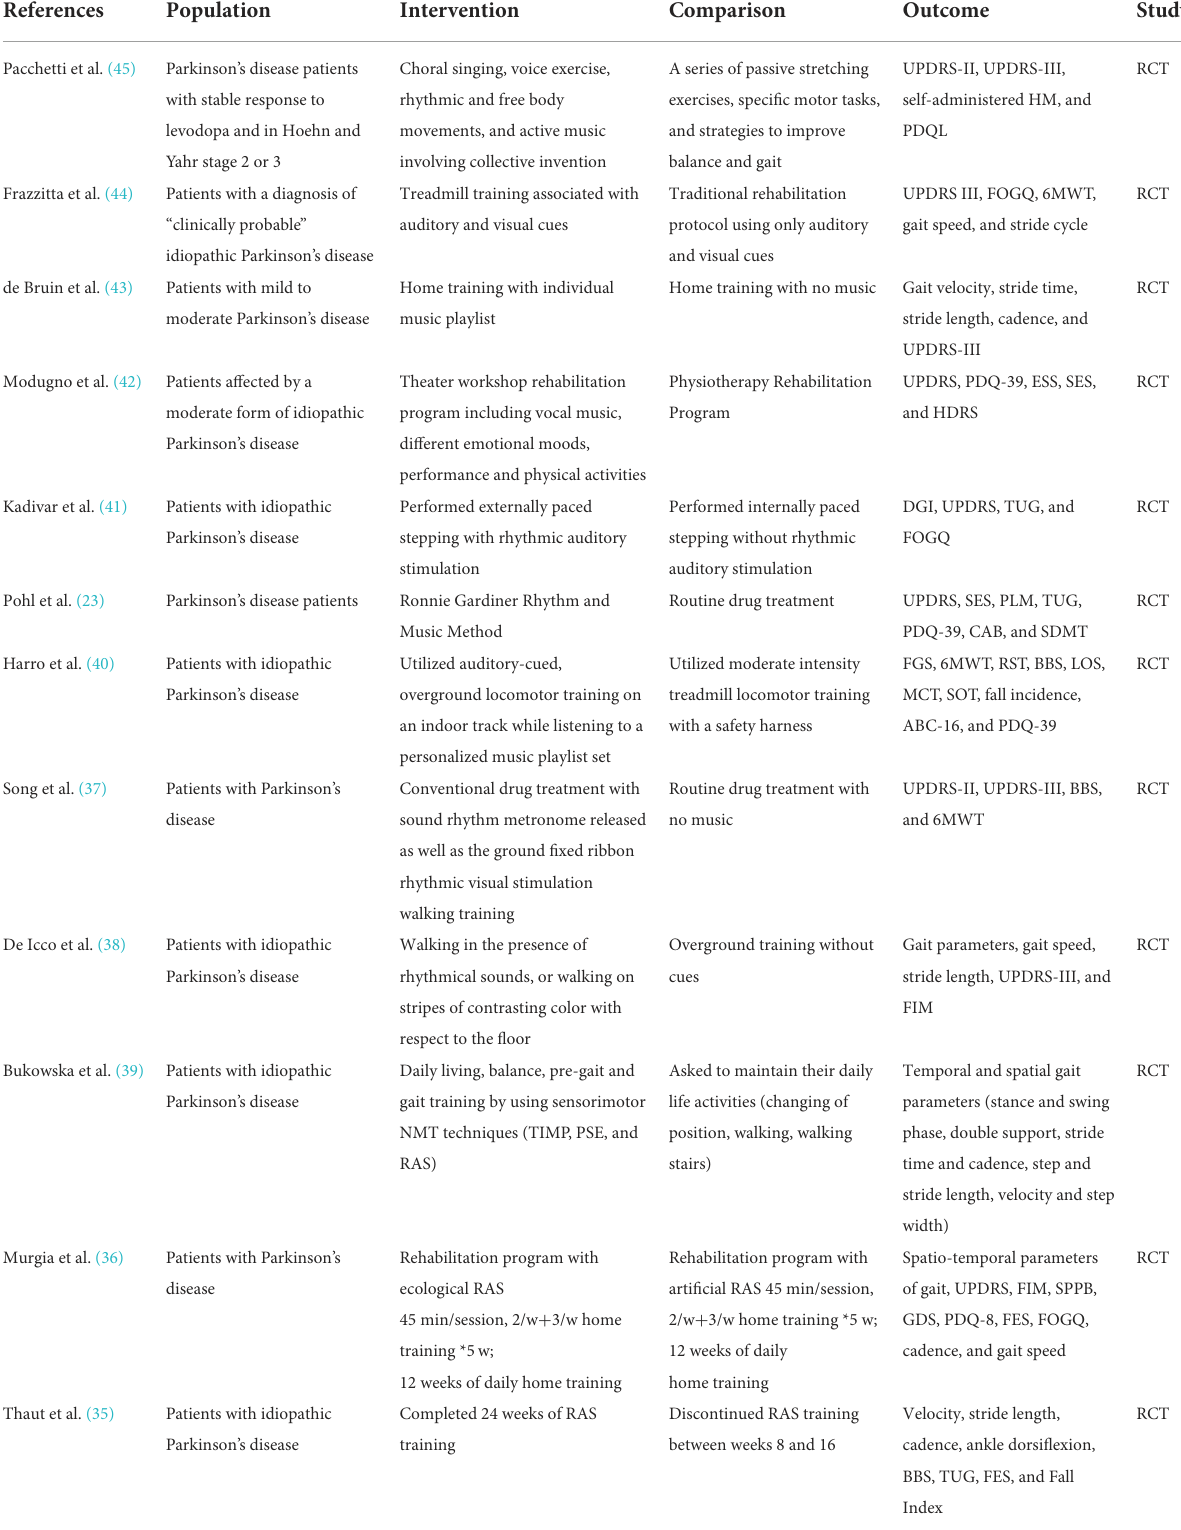
TABLE 2 PICOs (population, intervention, control, outcome and strategy) characteristics of the studies included in the